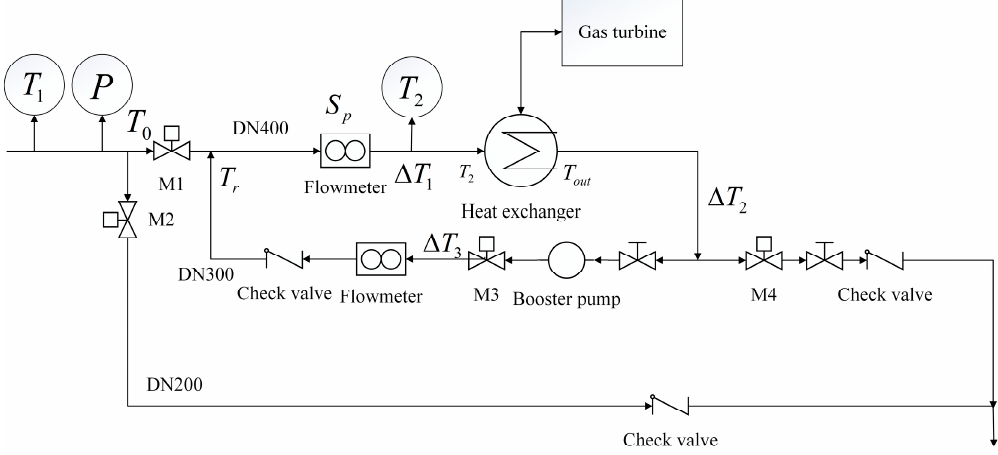
Figure 1. Gas turbine cooling system.